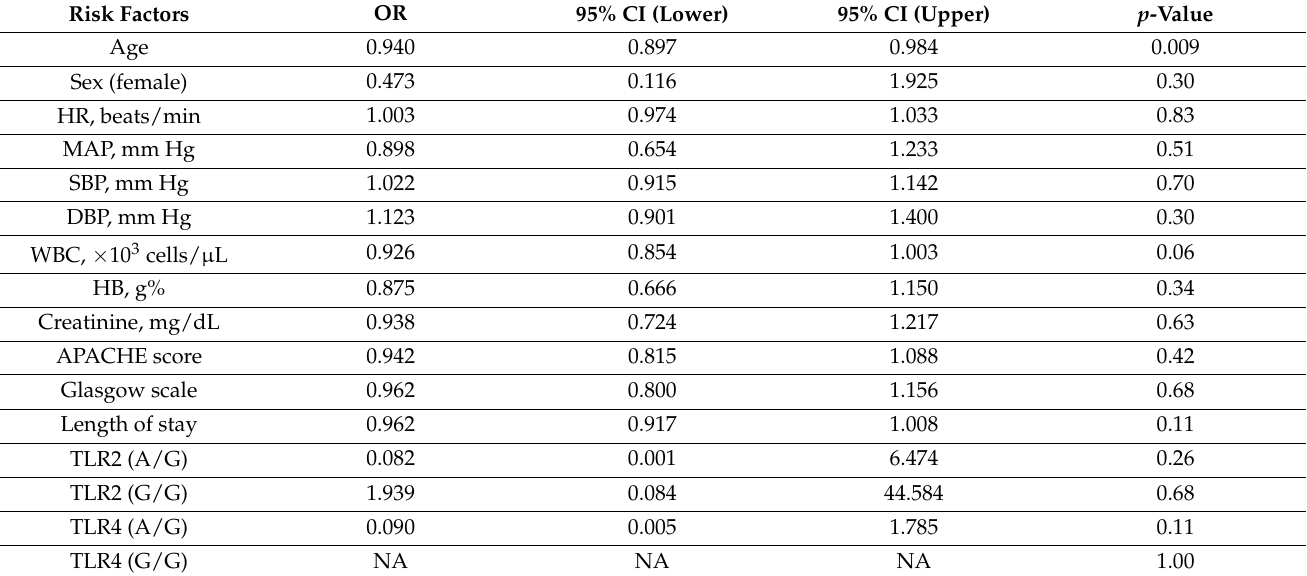
Table 6. Multivariate analysis for the risk of sepsis in ICU-admitted